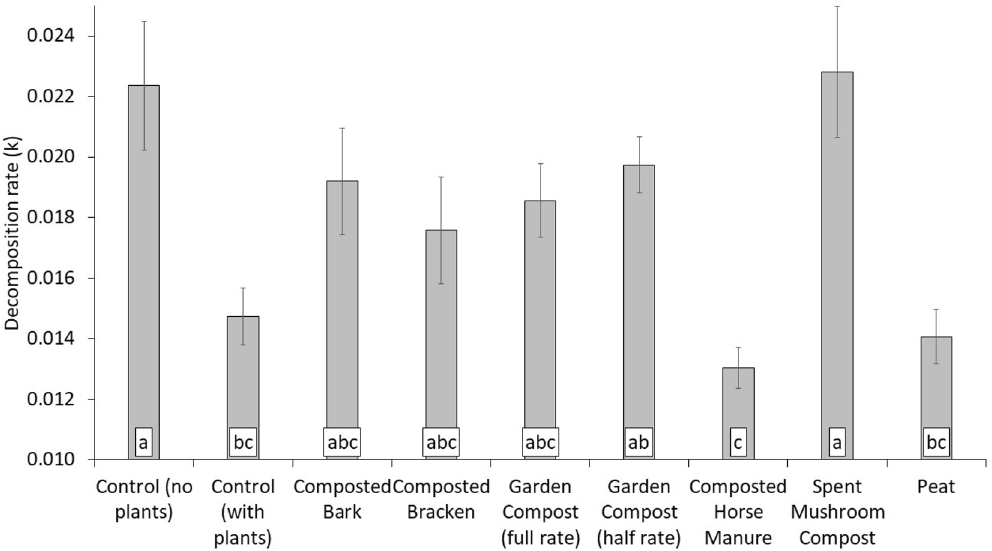
Figure 6. Decomposition rate under horticultural amendments according to the Tea Bag Index. Mean of eight replicate experimental plots in Year 6 (n = 8). Error bars for standard error. Treatments that share a lower-case letter label have no significant difference according to one-way ANOVA and Tukeys post-hoc testing ( p >